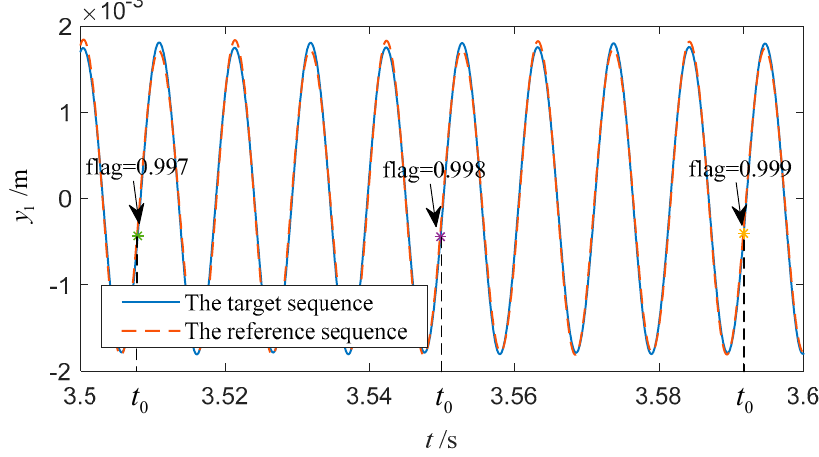
Figure 10. The results with different value of flag.